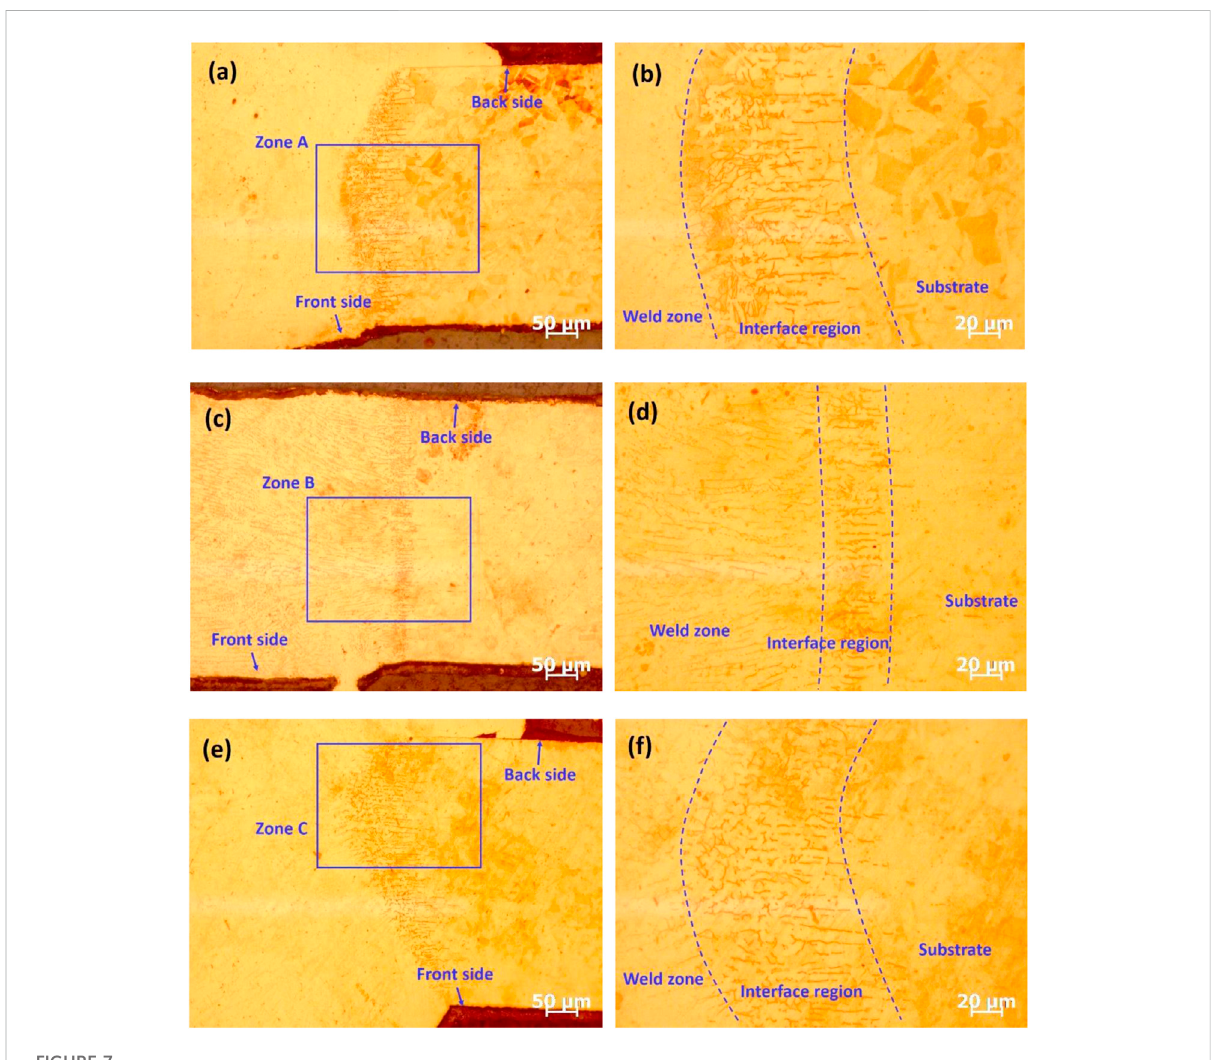
FIGURE 7 Microstructure of the interface region: (A,B) S11 (C,D) S4, and (E,F) S5.